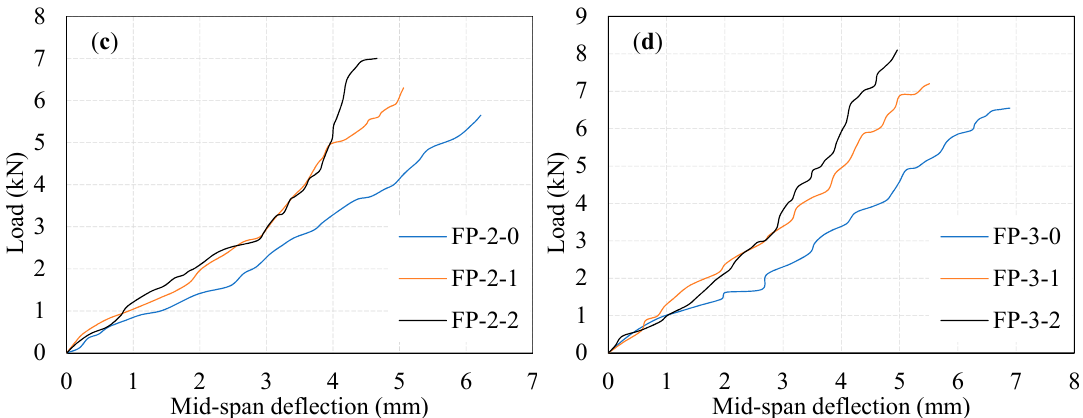
Figure 6. Load-mid span deflection profiles. ( a ) zero layer mesh; ( b ) one layer mesh; ( c ) two layer mesh and ( d ) three layer mesh.